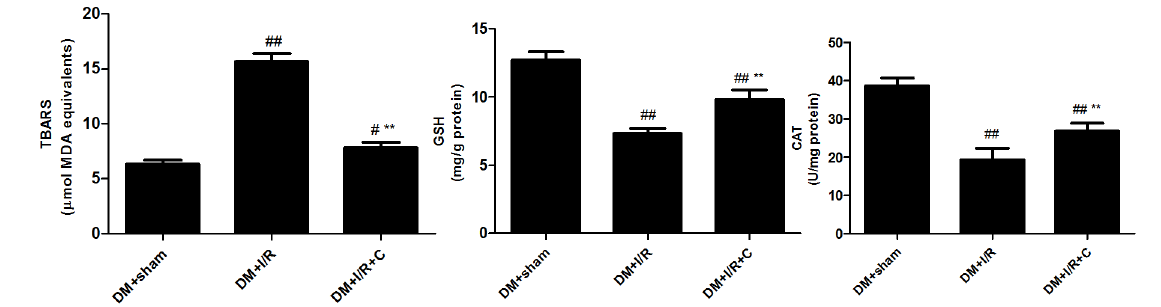
Figure 6. Effects of catalpol on serum and myocardial levels of inflammatory cytokines (TNF-α and IL-6). ## P < 0.01 versus